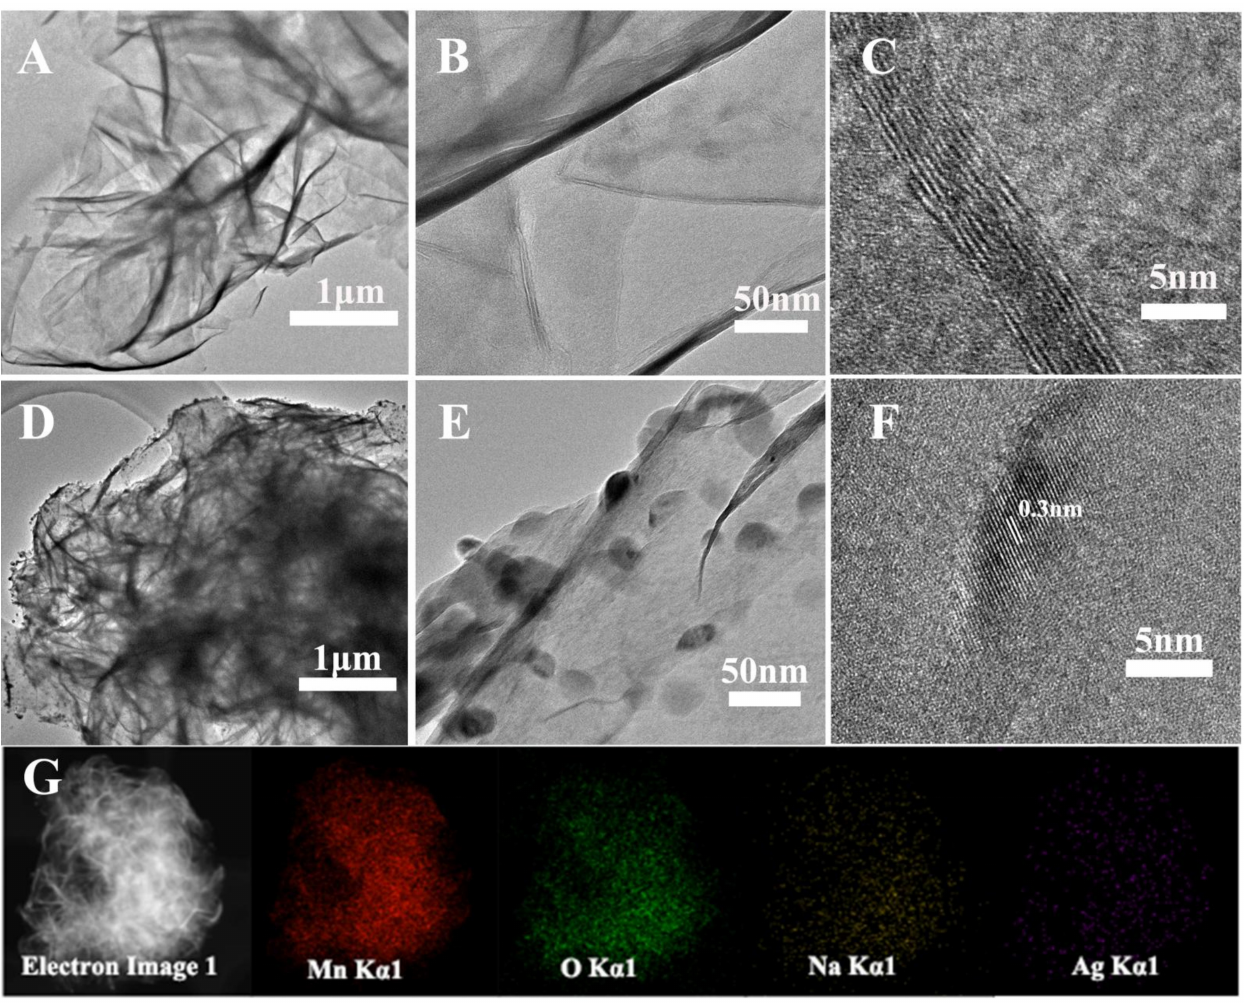
Figure 5. TEM images of Mn-Ag-0.00 ( A – C ), Mn- Ag-0.10 ( D – F ), and mapping of Mn-Ag-0.10 ( G ). To investigate the capacitive property of the new phase of AgMn 2 O 4 @Na 0.55 Mn 2 O 4 , we first evaluated the CV curves of the different samples, as shown in Figure 6A. The curves suggest a pair of distinct redox peaks at ca. 0.4 V and 0.1 V, which resulted from the insertion/extraction of ions during the charge and discharge process [32], the increased trend of current intensity with the added silver content, and the decreased trend as the molar ratio rose up to 15%. It is obvious that the maximum current response was achieved when the silver content was 10%. This result indicates that the sample of Mn-Ag-0.10 possessed the best pseudocapacitance properties, ascribed to the formation of a new phase of AgMn 2 O 4 . The values of these samples were 167.84 F g − 1 , 233.54 F g − 1 , 248.23 F g − 1 , and 191.92 F g − 1